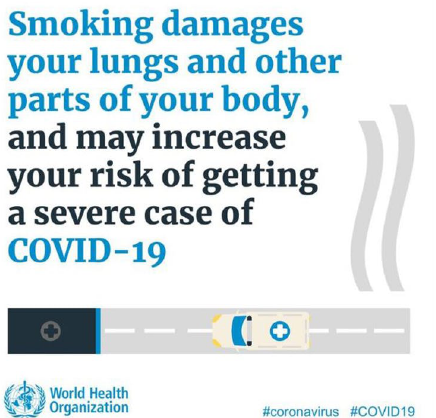
Figure 1 – Advertising by the World Health